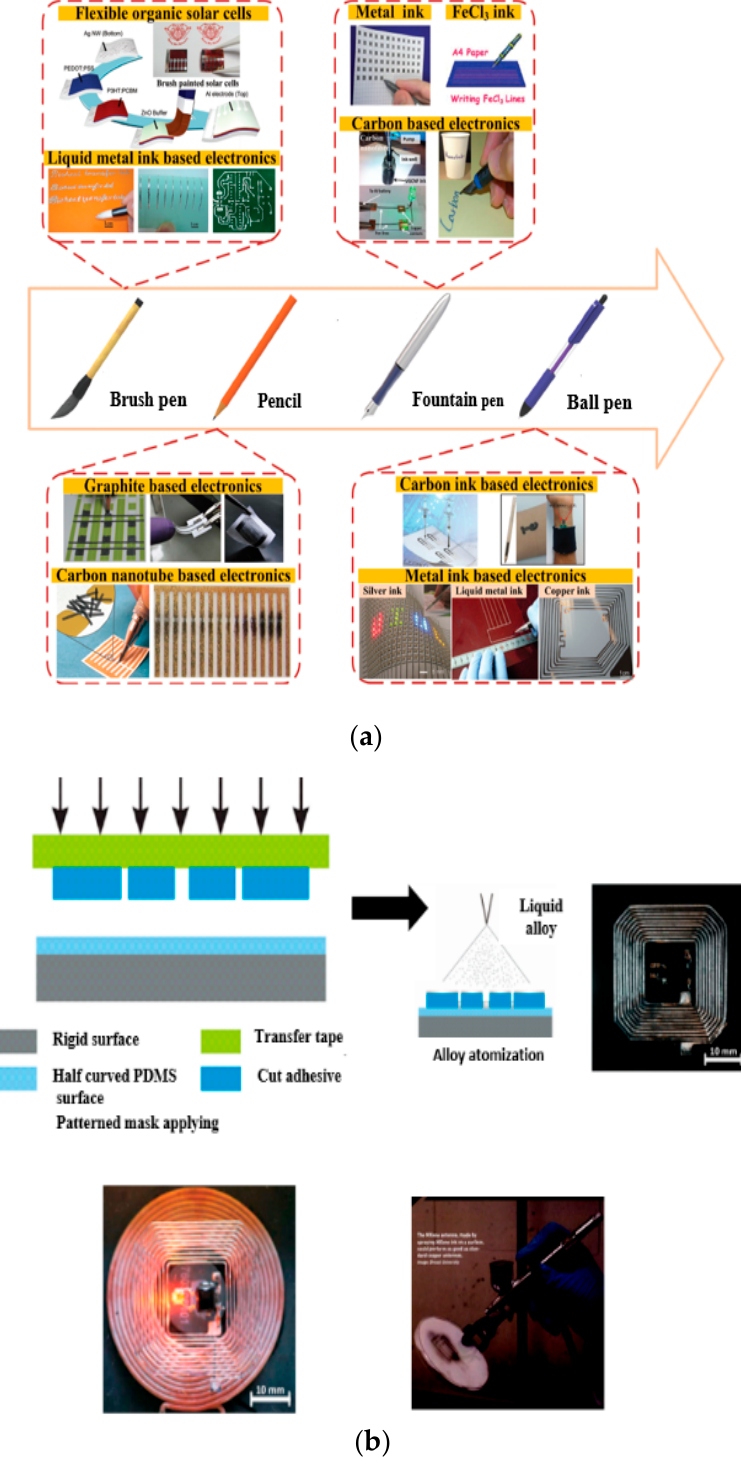
Figure 8. ( a ) Development in direct-writing electronics [260], ( b ) design of a spray painting method (Drexel’s spray paint antenna) [116,256]. Table 9. Comparison of handwriting methods [260].